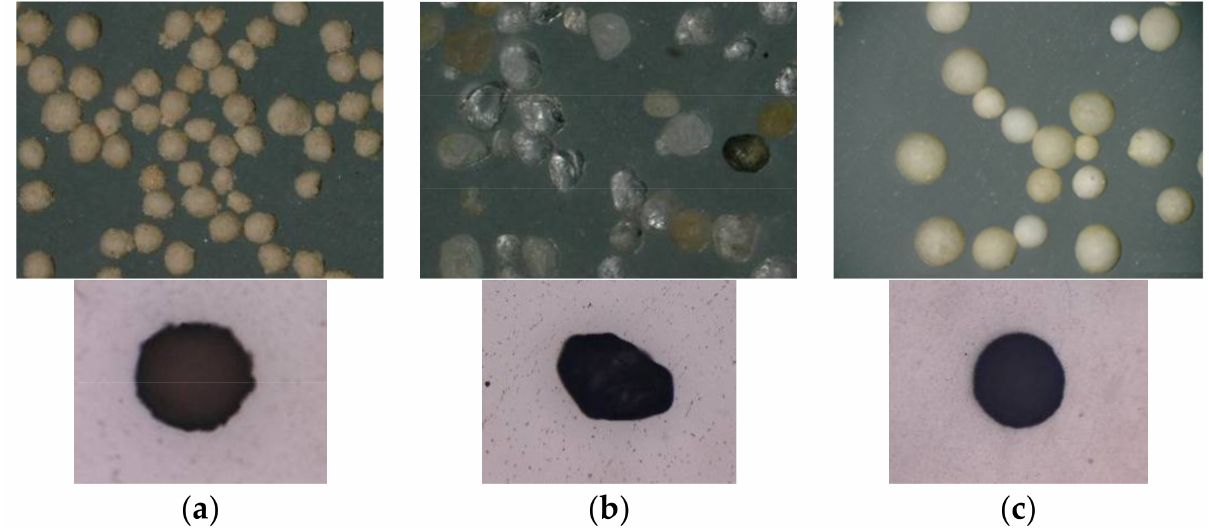
Figure 16. Morphology of different proppant particles. (( a – c ) are the morphology of ceramsite proppant, quartz sand proppant and solidified phase change